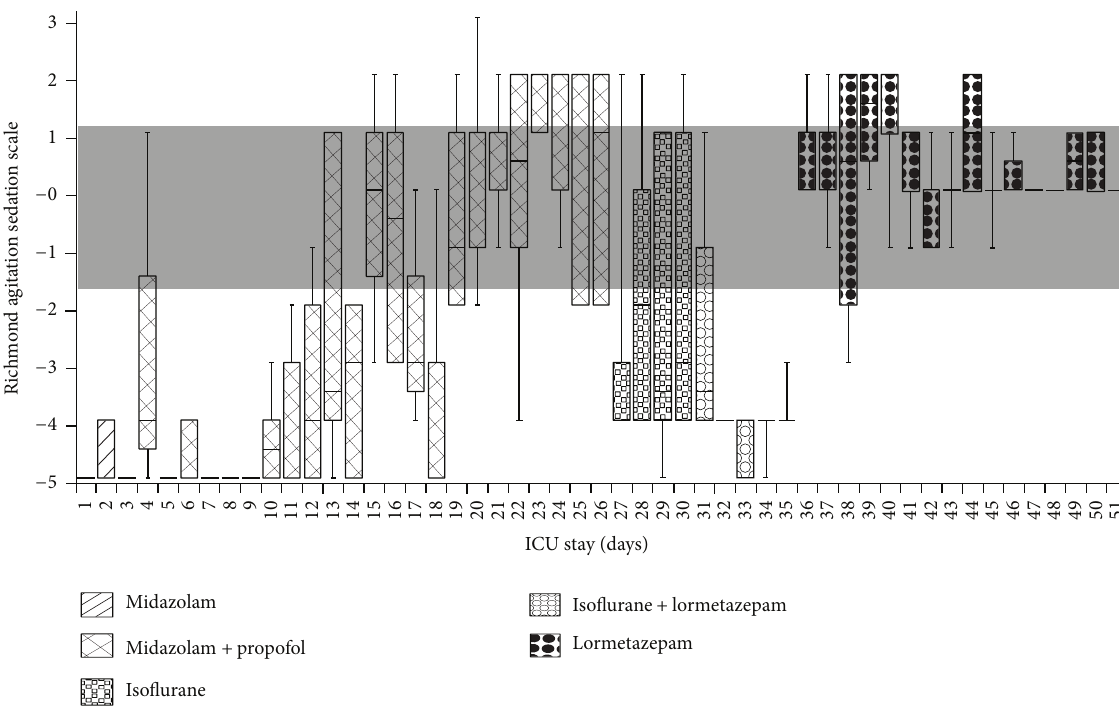
Figure 1: Levels of sedation and agitation. Measurement with the Richmond Agitation Sedation Scale (RASS) during intensive care unit treatment. The shadow indicates RASS − 1 to 0 (no sedation). Analgesia was performed with continious infusion of sufentanil until discharge from our intensive care